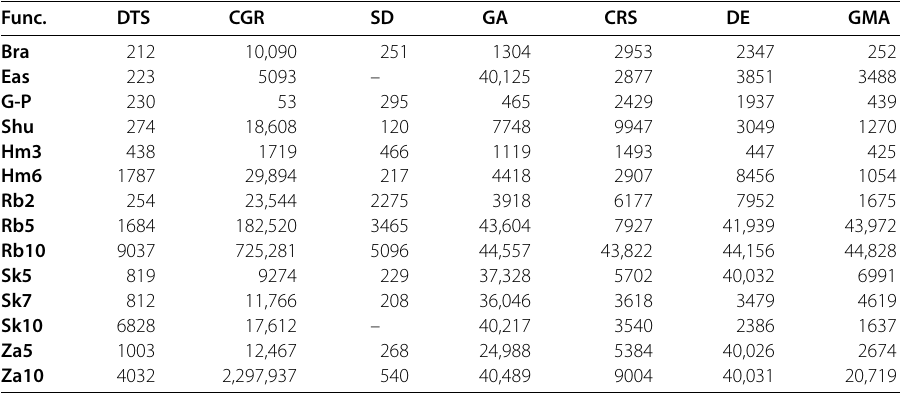
Table 2 Average number (considering only the runs satisfying the stopping criterion (7)) of evaluations needed by the optimization algorithms to solve the considered benchmark problems ( Func ) Func. DTS CGR DE